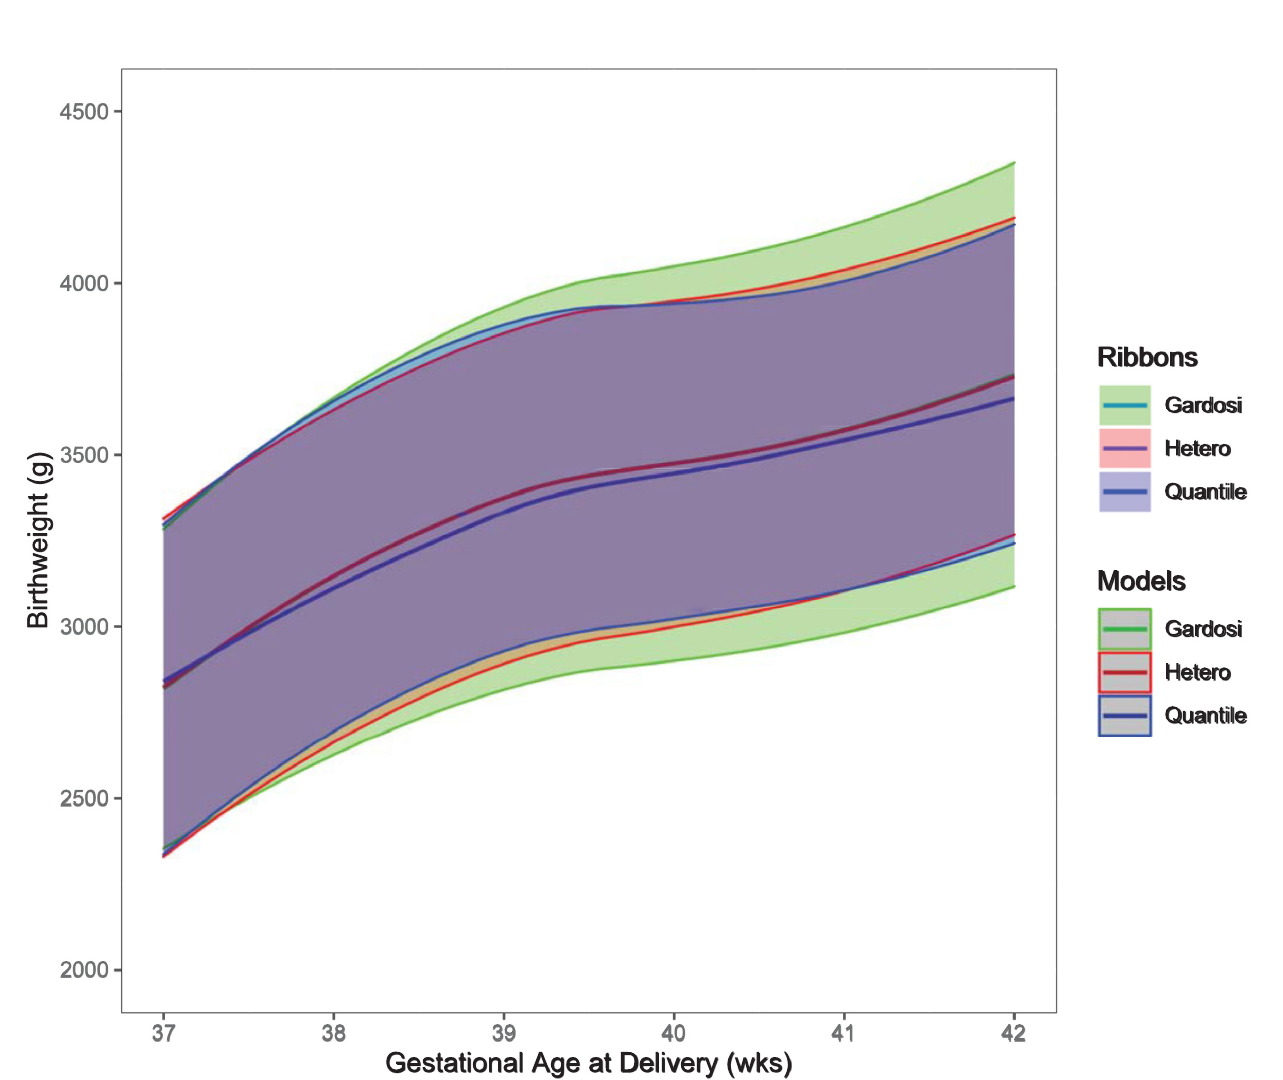
Fig 3. Comparison of the three customization models for birthweight at term. The 5 th , 10 th , 50 th , 90 th and 95 th percentiles for the Gardosi, heteroscedastic and quantile regression models for birthweight for deliveries at 37–41 weeks. Data are from the NICHD Fetal Growth Studies–Singleton. https://doi.org/10.1371/journal.pone.0282791.g003 birthweight and expected since the quantile regression is modeling the median of the distribu- tion rather than the mean. The standard deviations of the predicted birthweights were nar- rower for the customization models (248 g for Gardosi, 246 g for the heteroscedastic, and 234 g for the quantile regression) compared to 447 g for the observed birthweight. This difference can be explained because the extremes of the observed birthweight distribution are more widely dispersed than those of the predicted distributions. Such a phenomenon is not unex- pected. Since the customization models use measures of central tendency (i.e., mean/median), the predicted distributions of birthweights are well-aligned with the observed distribution at the center of the data. The discrepancy in the percentiles between the observed distributions and the predicted distributions are more pronounced toward the tail of the distribution, with the 10 th and the 90 th percentiles differing by two to three hundred grams.